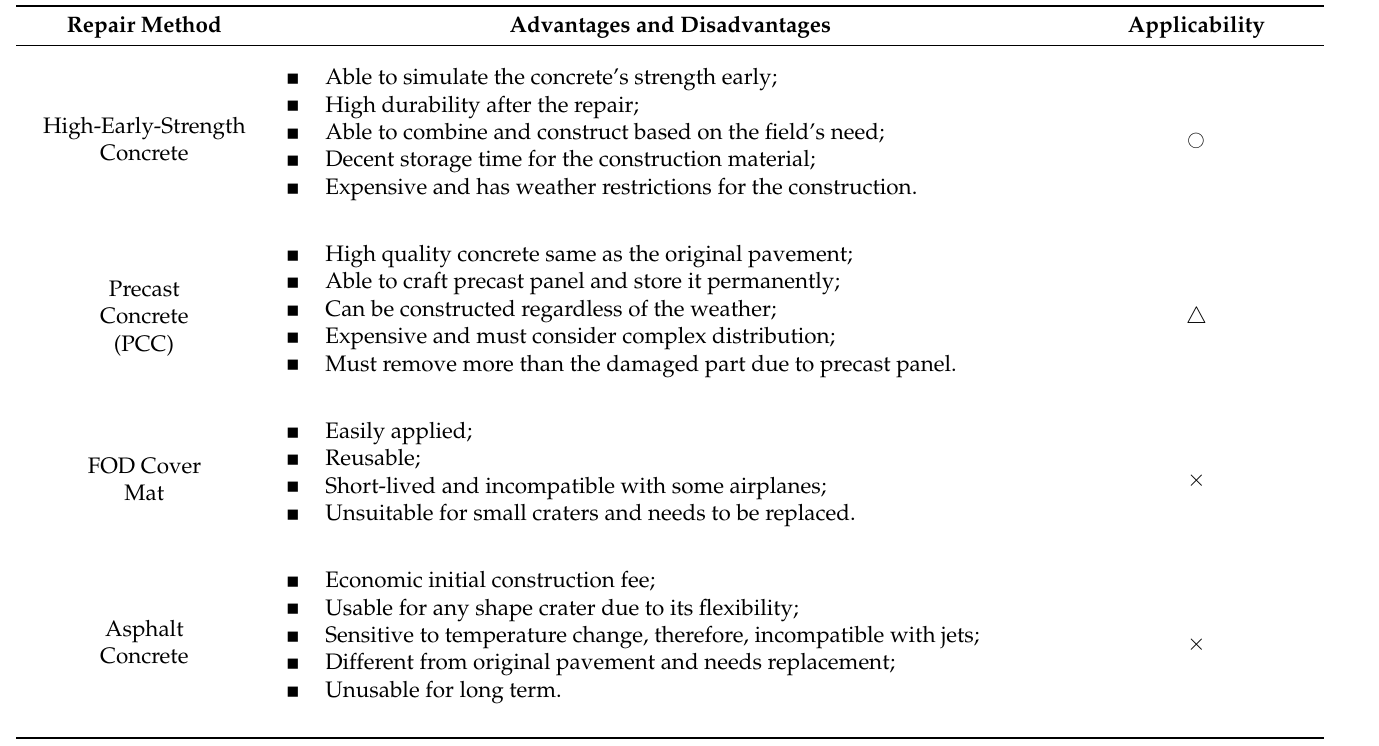
Table 7. Comparison and assessment of small crater repair methods.